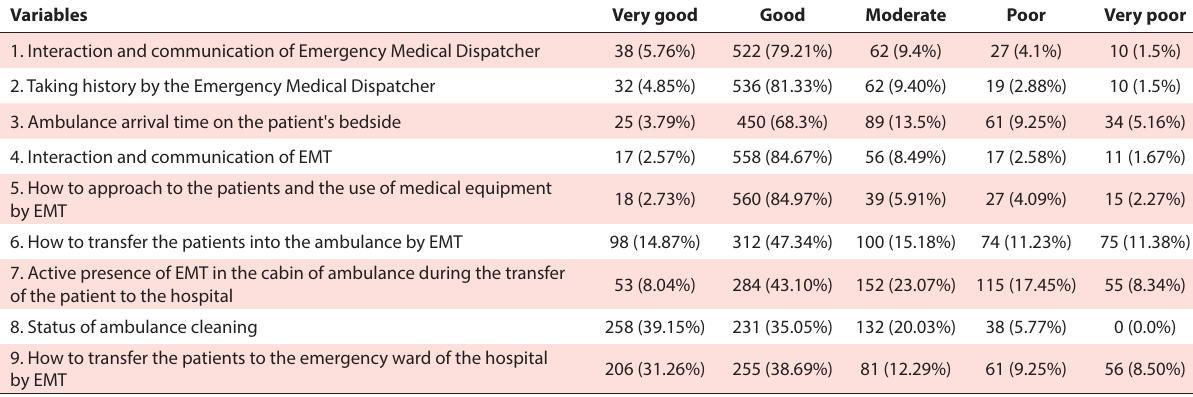
Table 1. Patients or their families’ opinions about prehospital emergency system